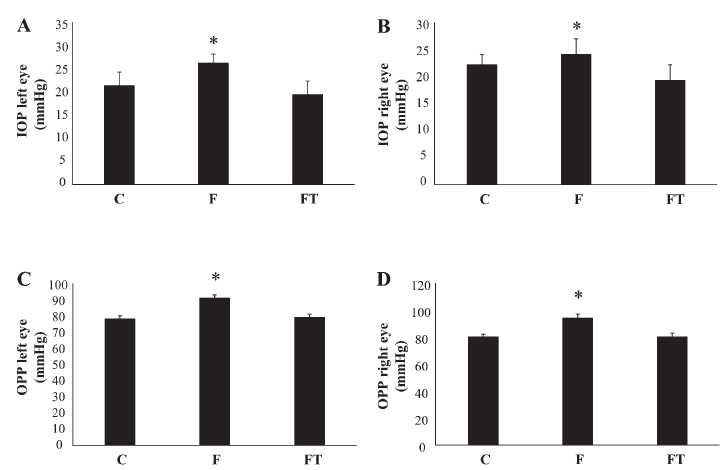
Figure 1. Intraocular pressure (IOP) and ocular perfusion pressure (OPP) in the left ( A and C ) and right ( B and D ) eyes. Data are reported as means±SE. F: sedentary fructose; FT: trained fructose. *P , 0.05 vs sedentary control (C) (one- way ANOVA followed by Student-Newman-Keuls post-test).